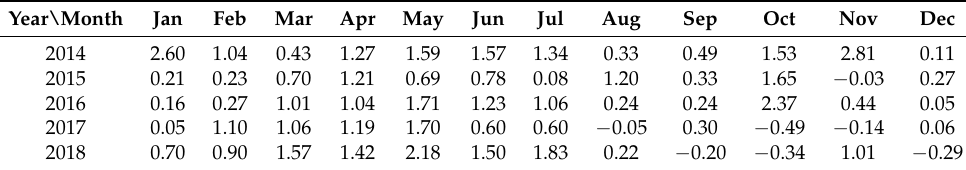
Table A11. Monthly maximums for sea surface height for the years 2014–2018.